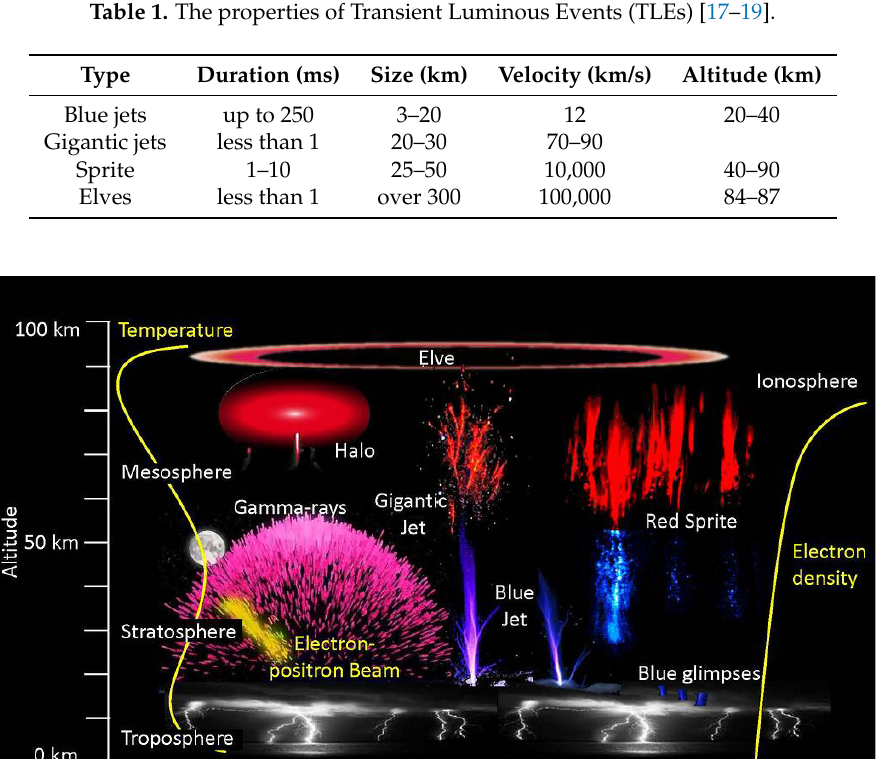
Figure 1. Representation of transient luminous events (elf, sprite, and blue jet) [20]. Elves are flat, round TLEs and occur in the thermosphere. Sprites are large-scale TLEs that mostly appear in the mesosphere. Blue jets are relatively small TLEs compared to sprites and they occur in the